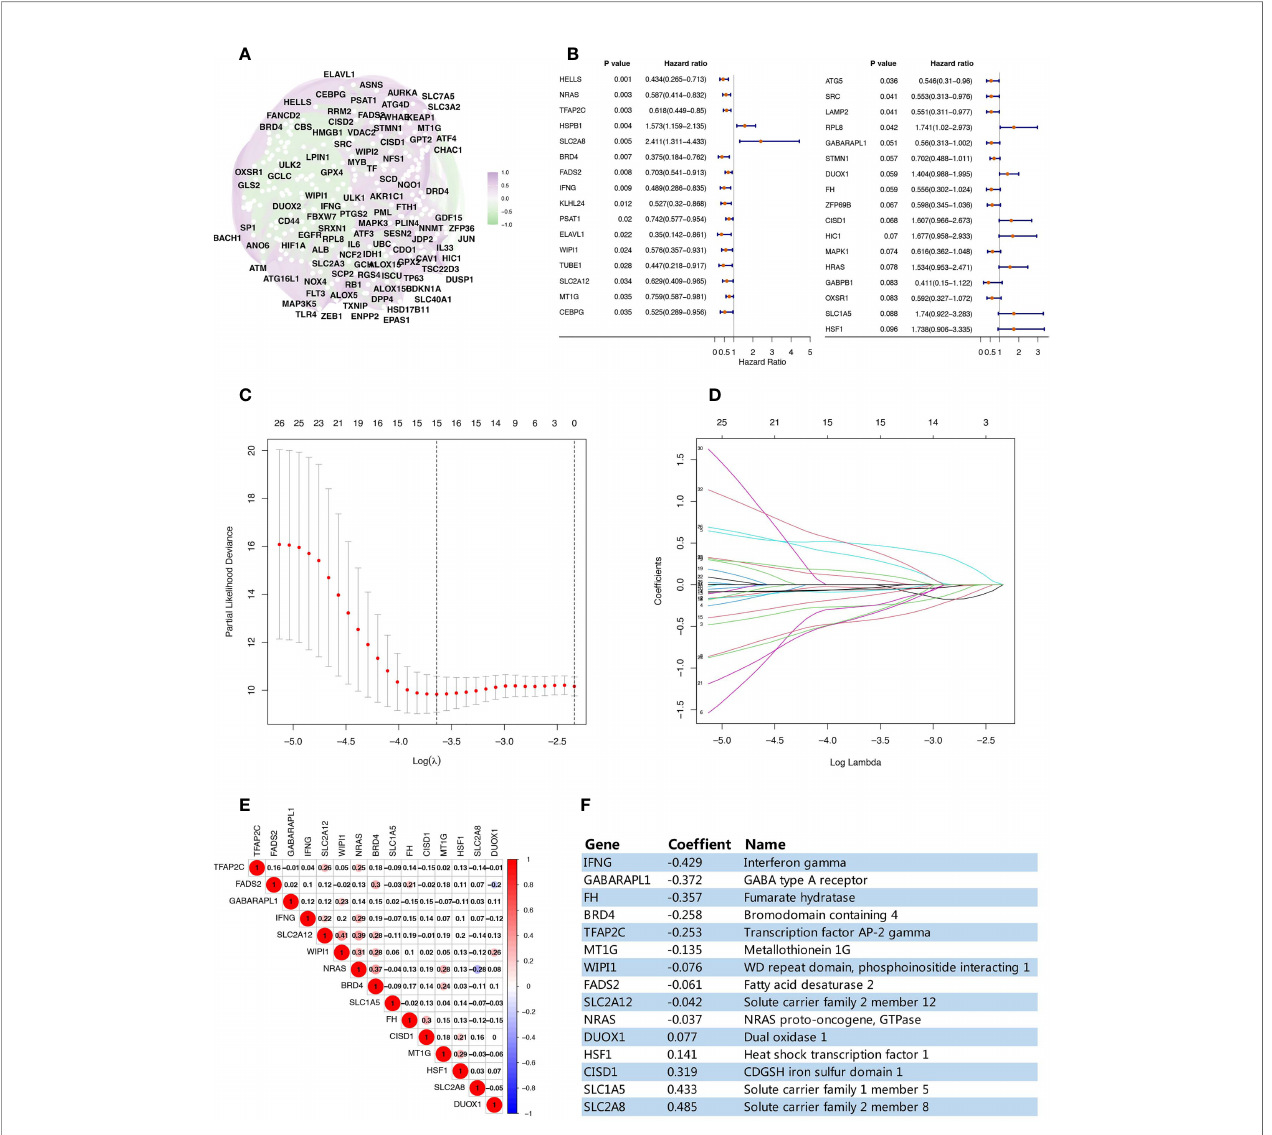
FIGURE 1 | Establishment of a prognostic ferroptosis-related gene pattern. (A) Correlation analysis of the ferroptosis-related genes. (B) Forest plots interpreting the univariate Cox analysis results between ferroptosis-related genes expression and OS. (C) Variables fi ltering based on Lasso regression. (D) Each curve represents the change trajectory of each ferroptosis-related genes coef fi cient. (E) Corplot showing the pairwise correlation analysis of these 15 ferroptosis-related genes. (F) The prognostic regression model established by LASSO regression